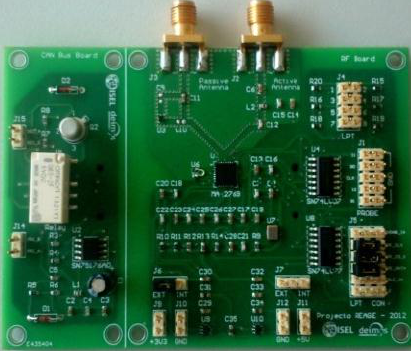
Figure 2. REAGE RF Core prototype (CAN interface on the left and RF front-end on the right).